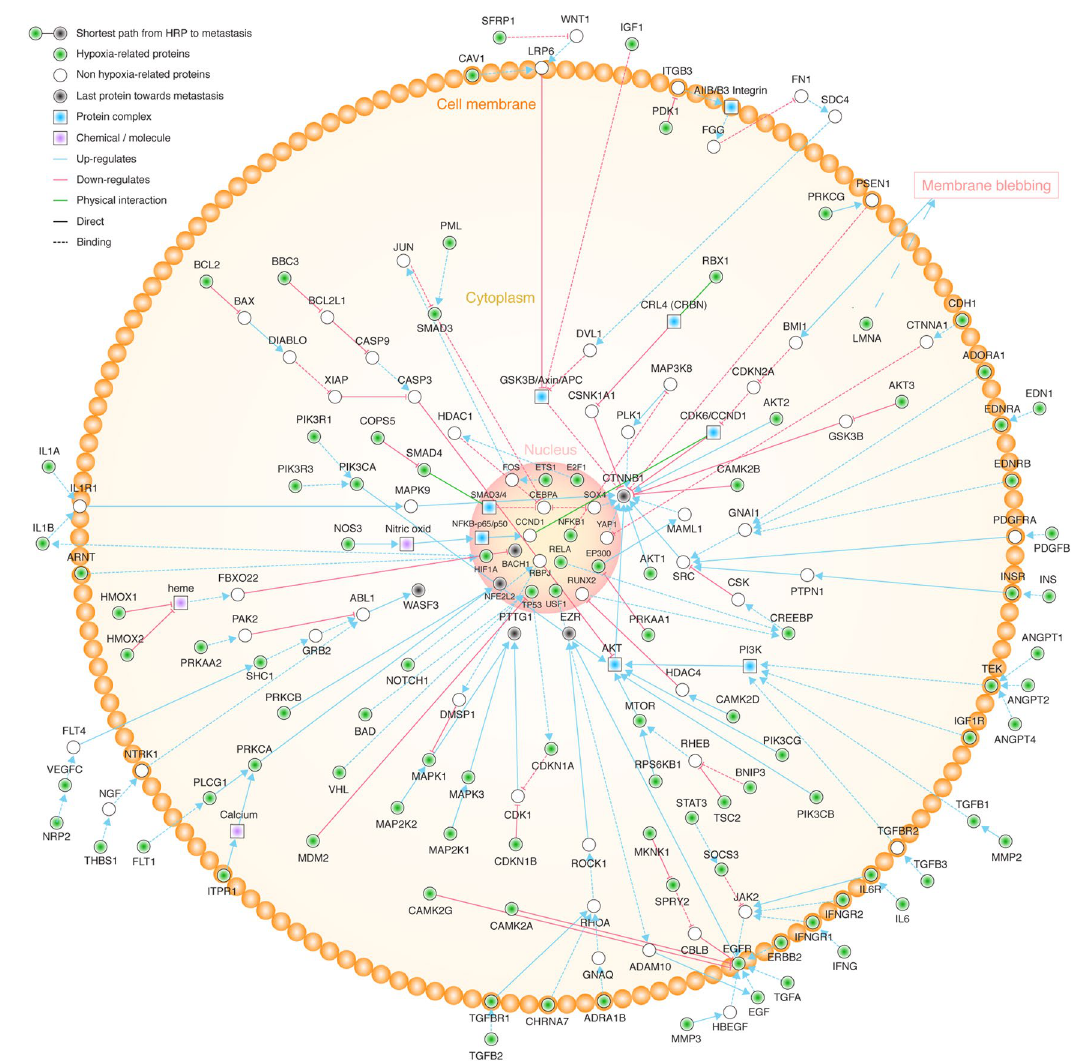
Figure 6. Cell overview of pathways with the shortest distance score from hypoxia-related proteins to the metastatic phenotype. HRP: hypoxia-related